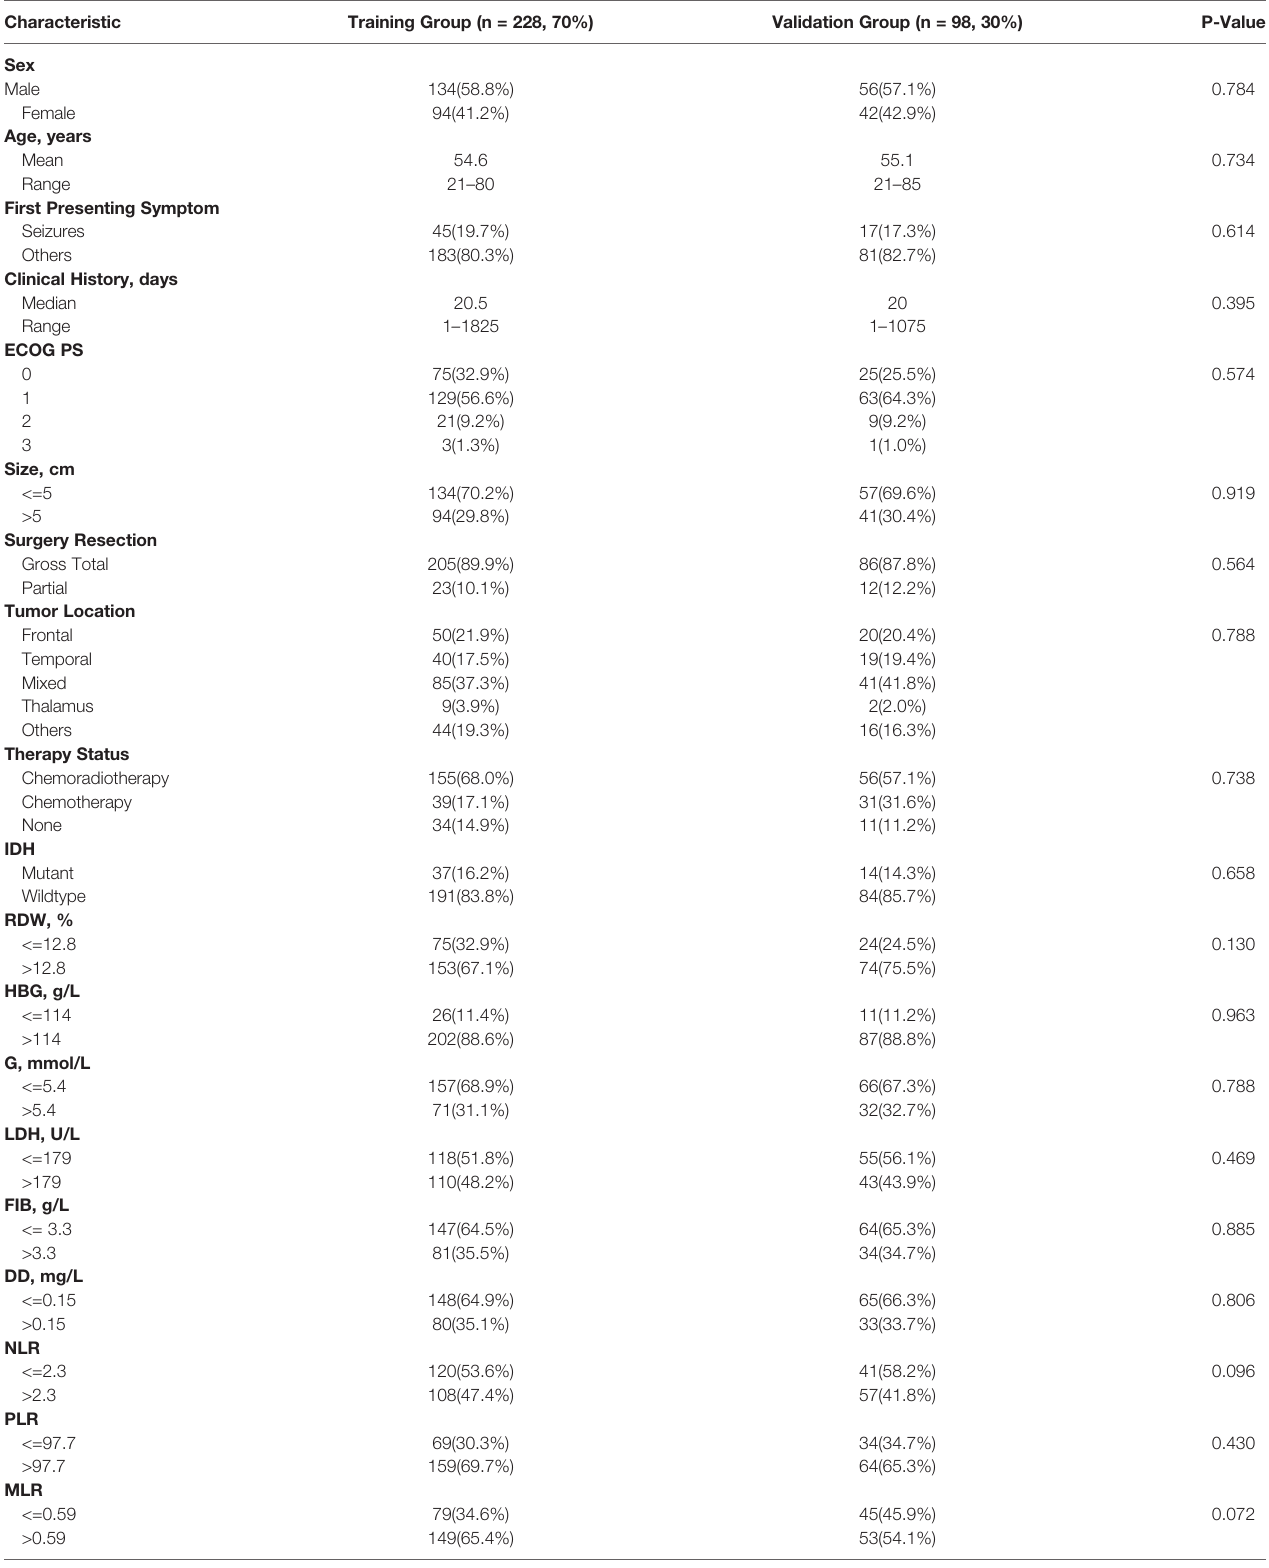
TABLE 1 | Summary of clinical characteristics of GBM